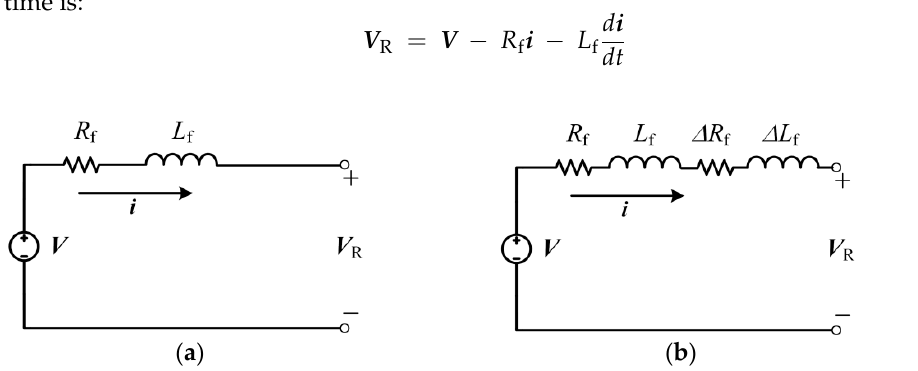
Figure 7. PWM Rectifier Single-Phase System Model: ( a ) Ideal single-phase system model. ( b ) Actual single-phase system model.